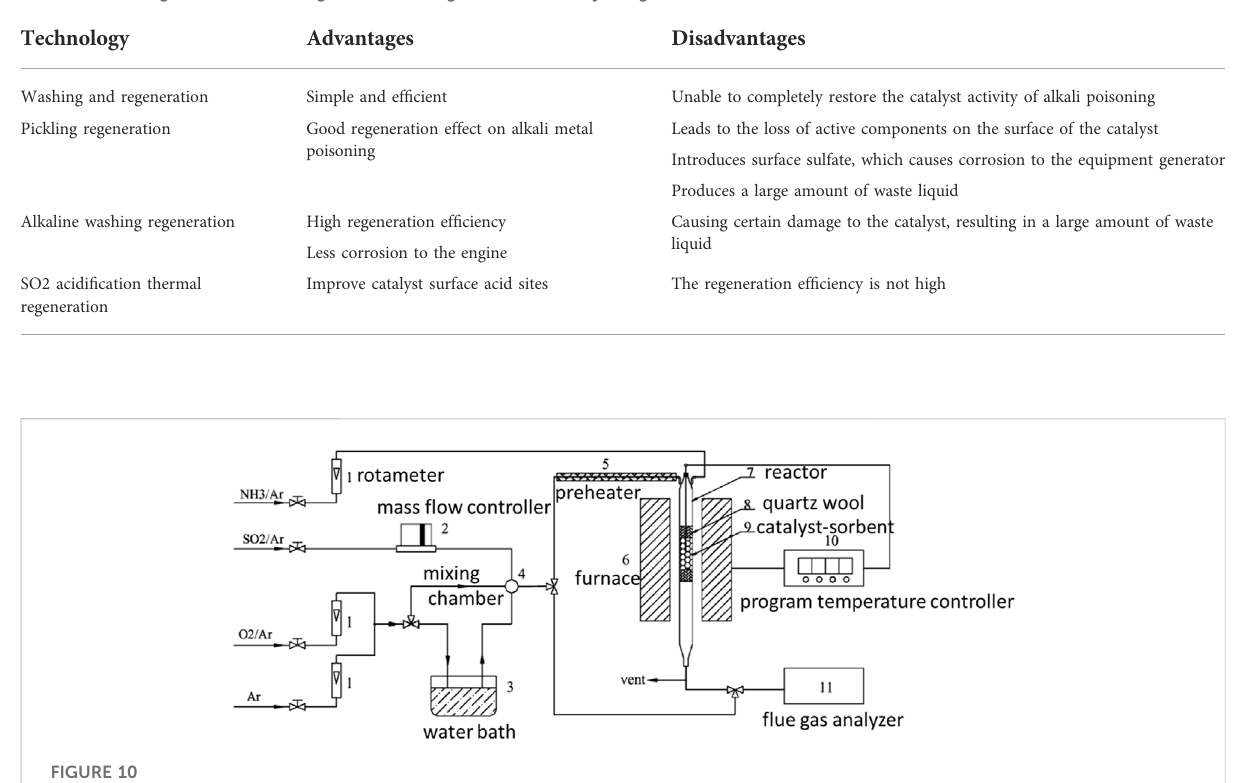
TABLE 1 Advantages and disadvantages of technologies for SCR catalyst regeneration.